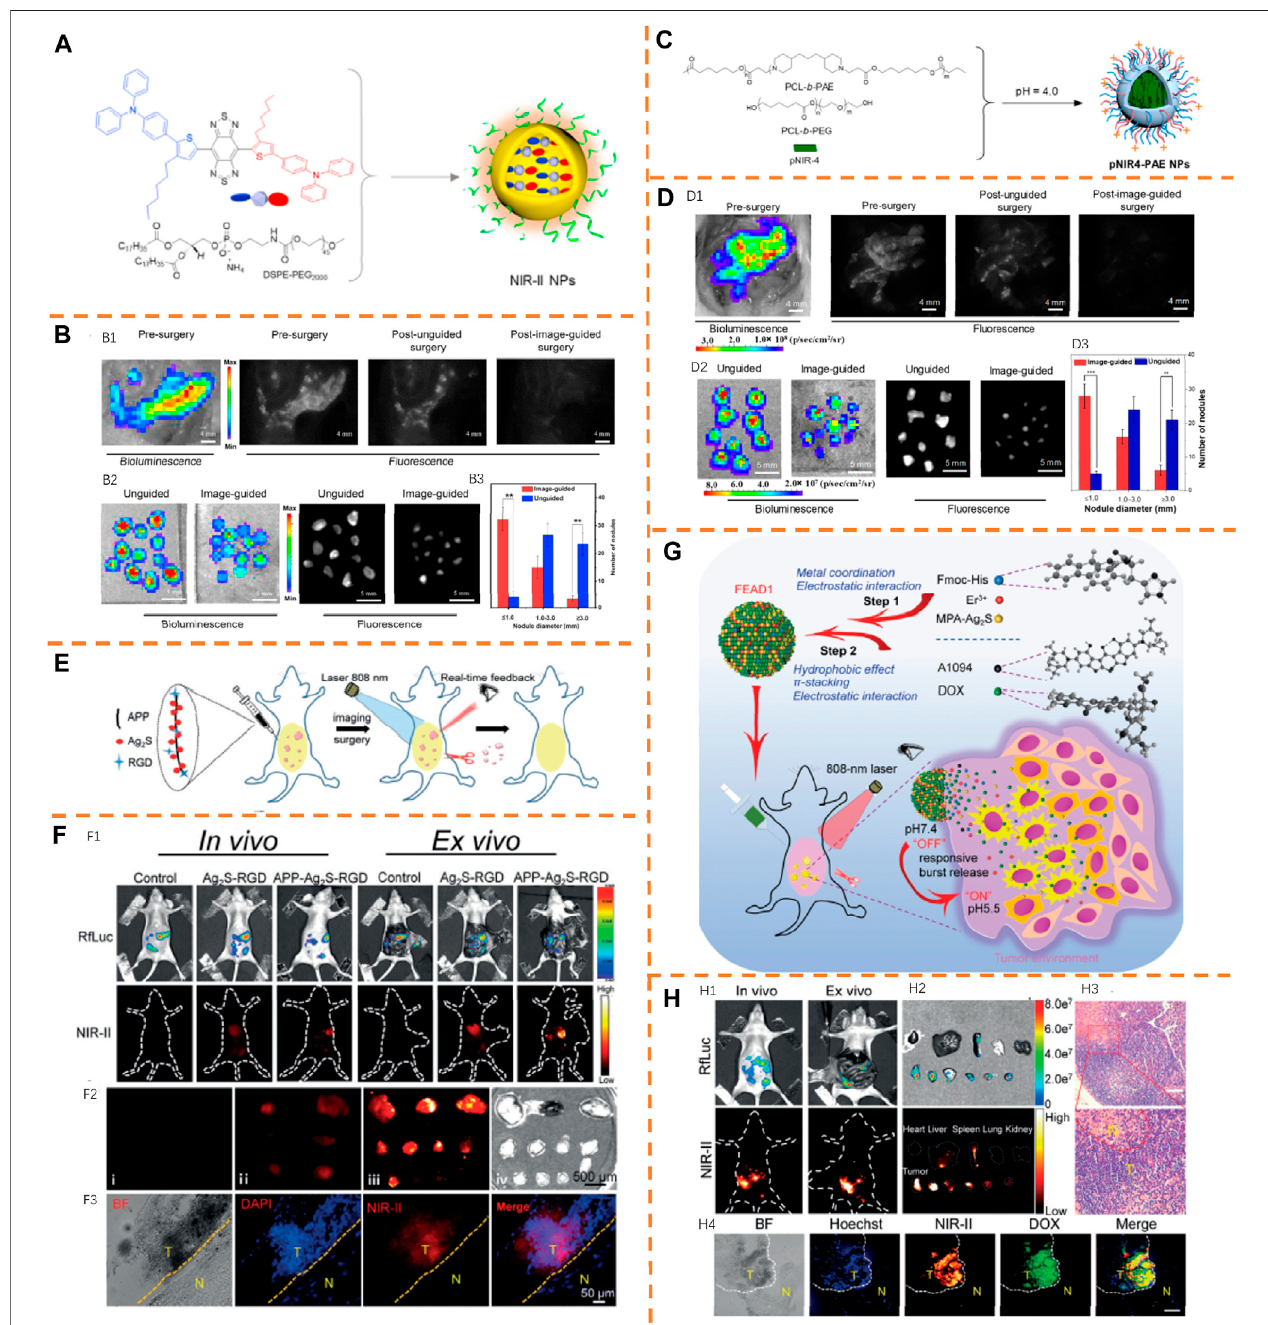
FIGURE 12 | (A) Preparation of 2TT-m, oC6B NPs with amphiphilic polymer DSPE-PEG 2000 . Adapted with permission from ref (Liu et al., 2020). (B) B1 : Bioluminescence and NIR-II imaging of the abdominal cavity before and after resecting the tumor. B2 : Bioluminescence and NIR-II fl uorescence signals of eliminated nodules of unguided and 2TT-m, oC6B NPs – guided groups. B3 : Histogram of nodule diameters resected from fl uorescence-guided and -unguided groups. (C) Schematic illustration of fabricating pNIR4-PAE NPs. Adapted with permission from Wen et al. (2019). (D) D1 : Bioluminescence and NIR-II imaging of the abdominal cavity before and after resecting the tumor. D2 : Bioluminescence and NIR-II imaging of the resected nodules of unguided and pNIR4-PAE NPs – guided groups. D3 : Statistical information of the resected nodule diameters. (E) Schematic explanation of the NIR-II fl uorescent nanochain probe APP-Ag 2 S-RGD for image- guided peritoneal carcinomatosis surgeries. Adapted with permission from Ling et al., 2020. (F) F1 : Bioluminescence and NIR-II pictures for preoperative and intraoperative phases after IP governance of either Ag 2 S-RGD or APP-Ag 2 S-RGD. F2 : NIR-II fl uorescence images of tumor nodules excised with the naked eye (i) and NIR-II fl uorescent imaging guidance (ii: Ag 2 S-RGD, iii: APP-Ag 2 S-RGD); iv) bright- fi eld image associated with the (iii). F3: Bright- fi eld and fl uorescence images of the tumor slice procured from the APP-Ag 2 S-RGD-guided surgery using a multi-channel fl uorescence microscope. (G) Schematic illustration of constructing FEAD1 and ability to accurately diagnose and treat the tumor in peritoneal metastasis. Adapted with consent from Ling et al. (2020). (H) H1 : NIR-II and bioluminescence imaging of preoperative phasing of intraperitoneally injecting the peritoneal metastasis model of FEAD1. H2 : NIR-II fl uorescent and bioluminescence imaging of tumor nodules excised. H3 : H&E staining of the tumor slice. H4 : Fluorescence imaging of the tumor slice procured from the tumor nodules excised.